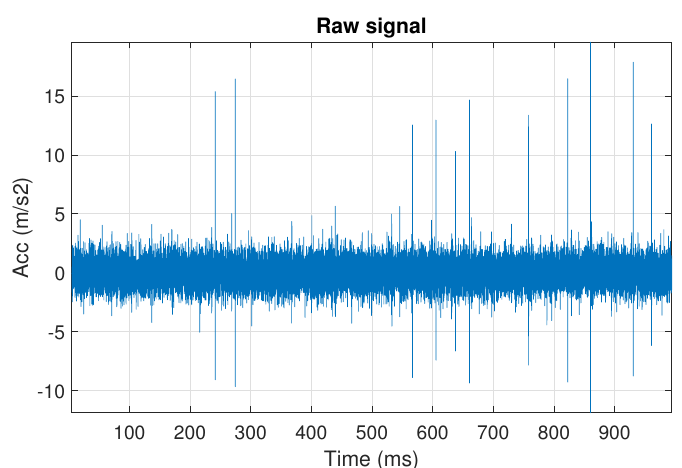
Figure 11. The simulated signal s 2 . It corresponds to the case presented in Figure 1b.